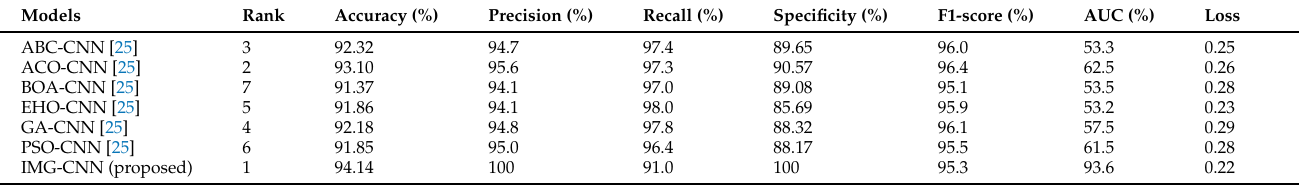
Table 11. Comparison of the performance evaluation metrics of the different models presented in previous studies and our proposed IMG-CNN model using deep learning